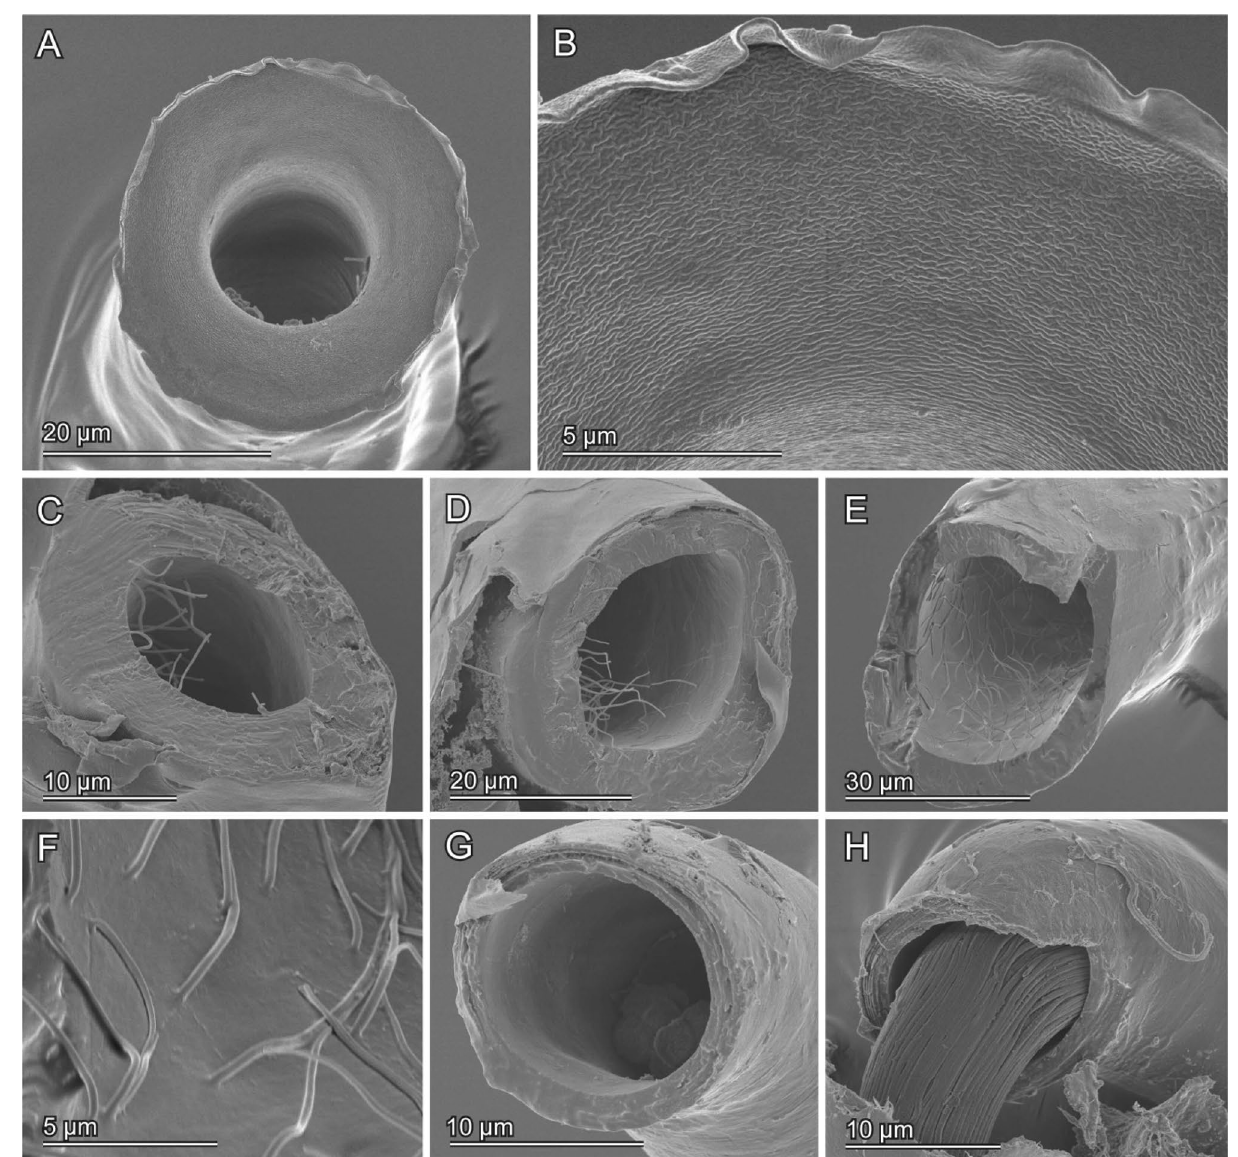
Figure 6. Geometry of the virga and spermatheca of Echinosom denticulatum . Scanning electron micrographs of the virga ( A – F ) and the spermatheca ( G , H ). ( A ) The very tip of the virga. ( B ) A magnified image of the tip of the virga. ( C – F ) Cross-sections of the virga at the apex ( C ), at the middle ( D ) and at the base ( E ). ( F ) A magnified surface images of the inner surface of the virga. ( G , H ) Cross-sections of the spermatheca. Spermatozoa are visible ( H